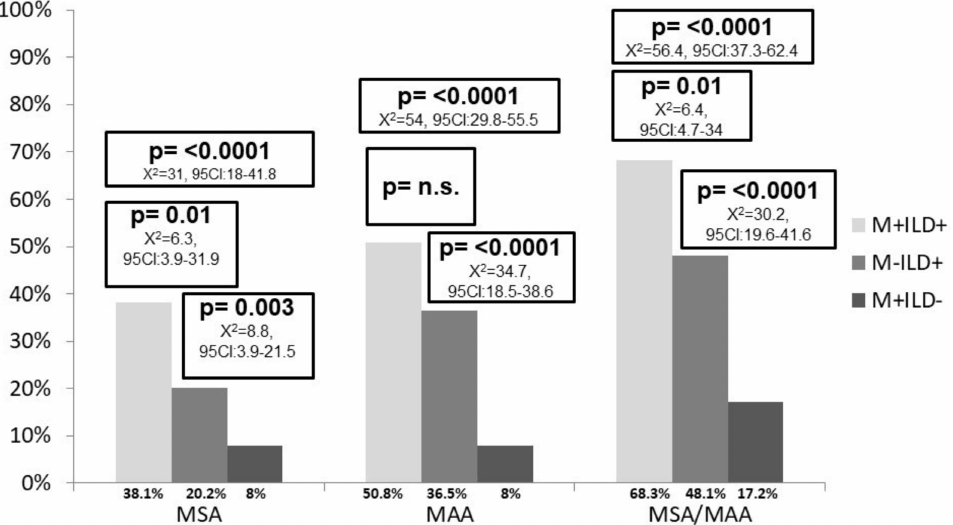
Figure 2. Proportion of MSA/MAA positivity in the three cohorts studied. Figure 2 legend: ILD: interstitial lung Disease; M: myalgia; MAA: myositis-associated antibodies; MSA: myositis-specific antibodies. Regarding MSA/MAA, we did not find differences in prevalence between M+ILD+ and M-ILD+ patients. M+ILD- patients showed a lower prevalence of anti-Jo1 than both of the other groups (vs. M+ILD+ p = 0.0001, vs. M-ILD+ p = 0.0005), and similar results were noted with anti-Ro52Kd (vs. both of the other groups p = < 0.0001). M+ILD- also had a lower prevalence of anti-PL7 ( p = 0.006), anti-Pm/scl ( p = 0.007) and anti-RNP ( p = 0.04) compared with M+ILD+ patients. The prevalence of each autoantibody tested in the three groups is reported in Table S1 (Supplementary Materials). Multiple seropositivity for MSA/MAA was found in 20.6% of M+ILD+, 11.5% of M-ILD+ and 4% of